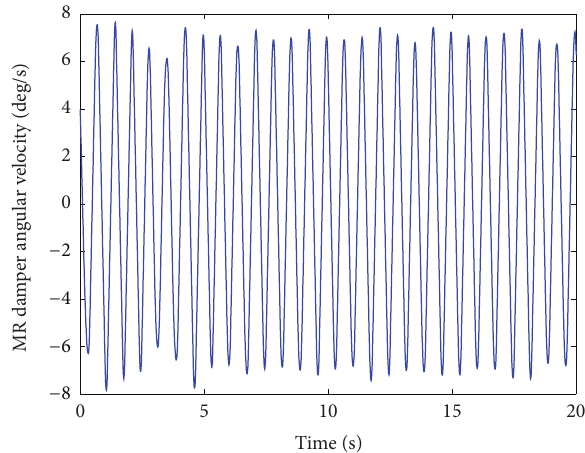
Figure 8: Tracking results of MR damper angular velocity with a continuous sinusoidal excitement.